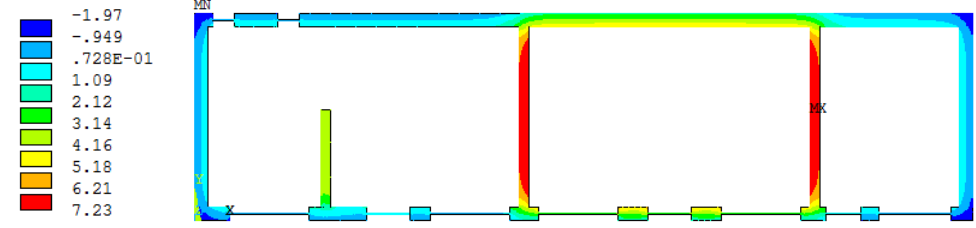
Figure 8. Temperature distributions in the walls with natural convection on the surface.